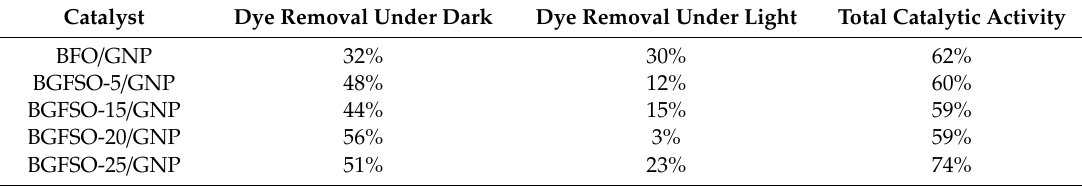
Catalyst Dye Removal Under Dark Dye Removal Under Light Total Catalytic